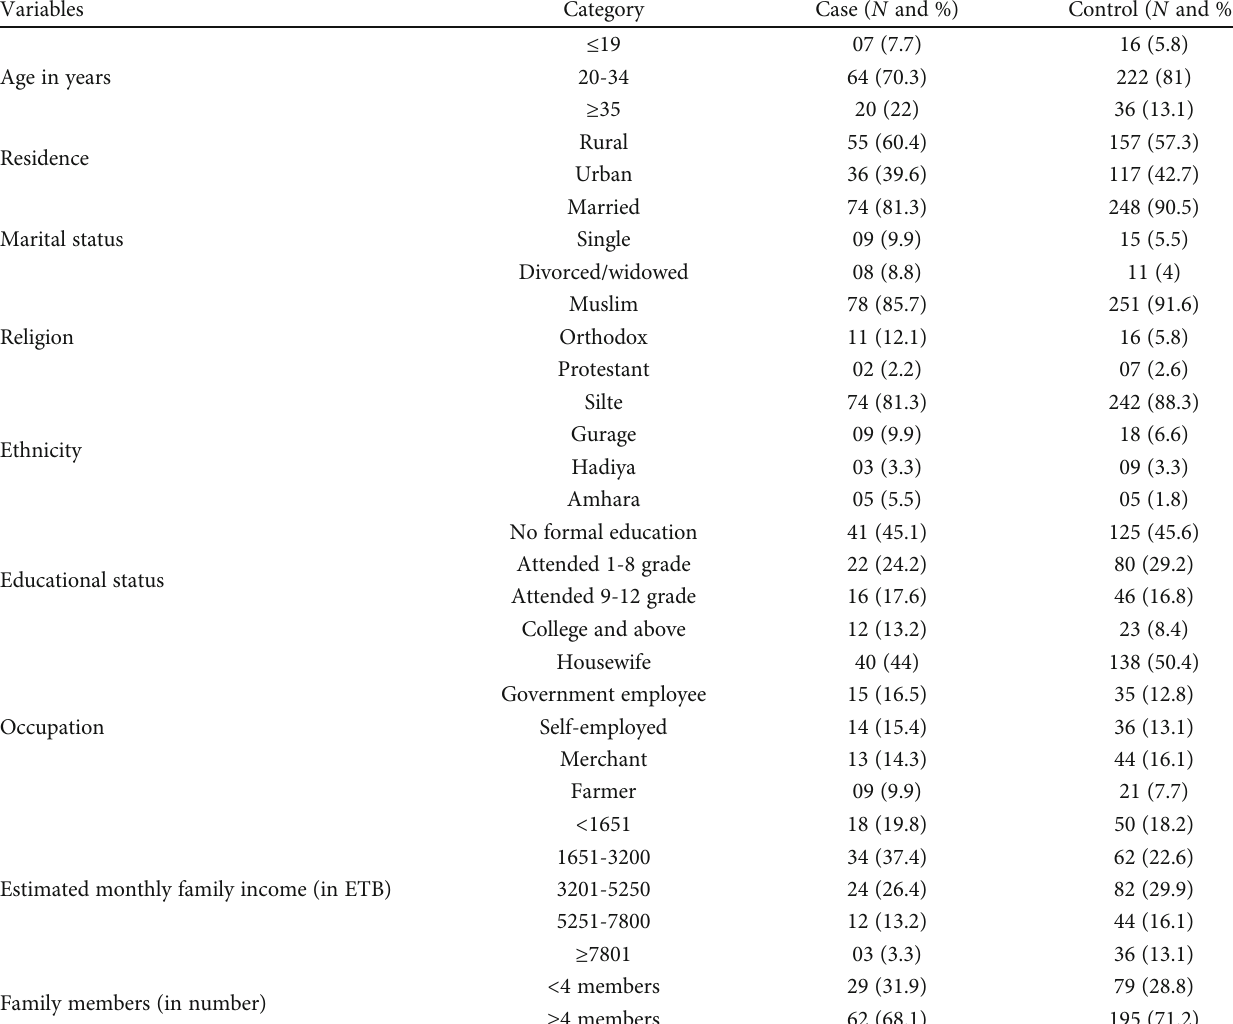
Table 1: Sociodemographic characteristics of mothers who gave birth in Silte Zone Public Hospitals, Southern Ethiopia (2019/20).